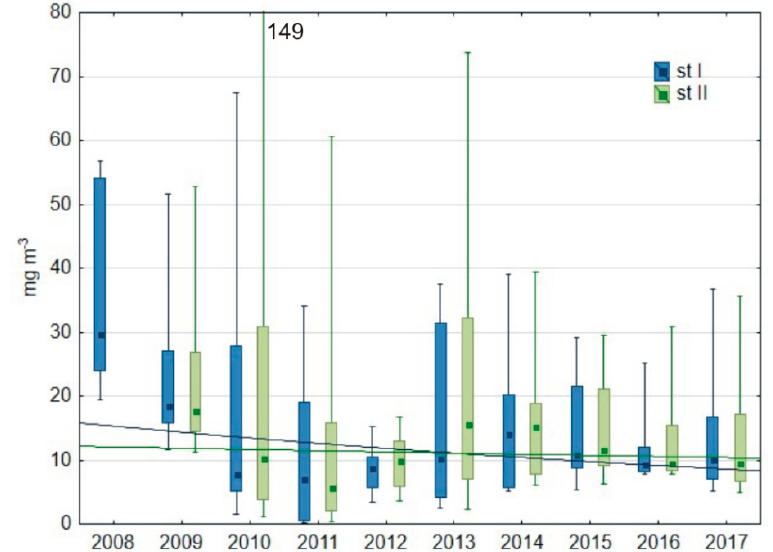
Figure 7. Box plot with min-max of chlorophyll-a in epilimnion at both stations I. The lines indicate exponential trendlines for each station.